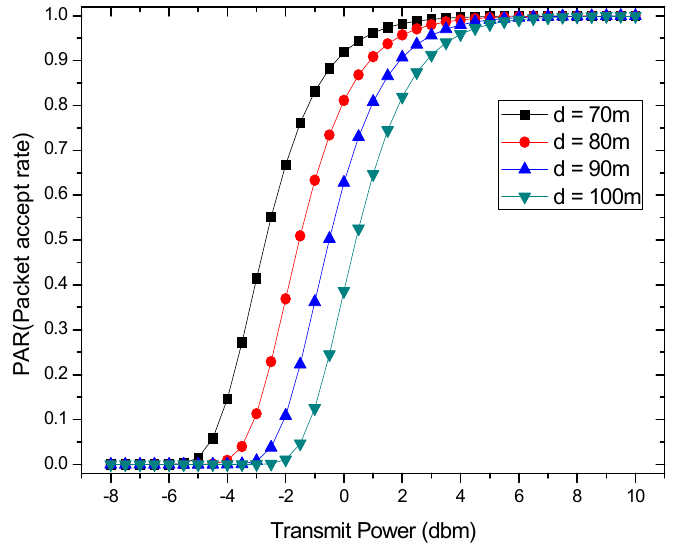
Figure 4. Packet acceptance rate and transmit power.